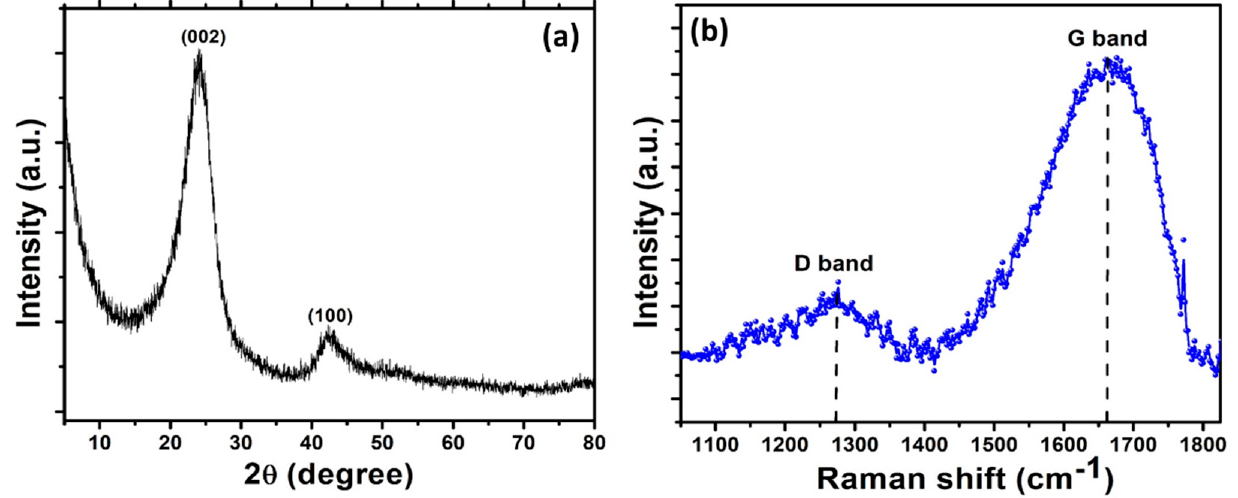
Figure 1. ( a ) XRD patterns and ( b ) Raman spectrum of activated carbon prepared using rice husk.